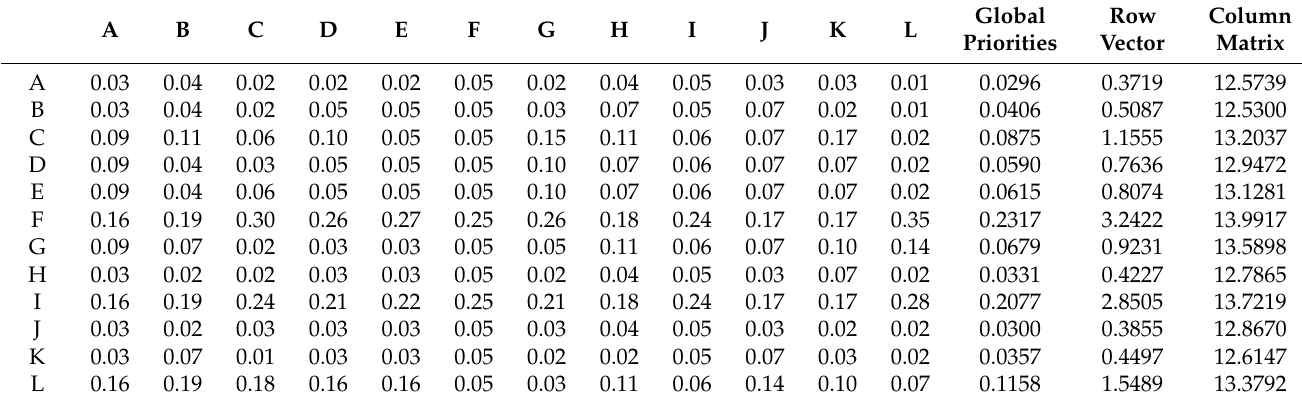
Table 7. Normalized matrix of pairwise comparison (first iteration).